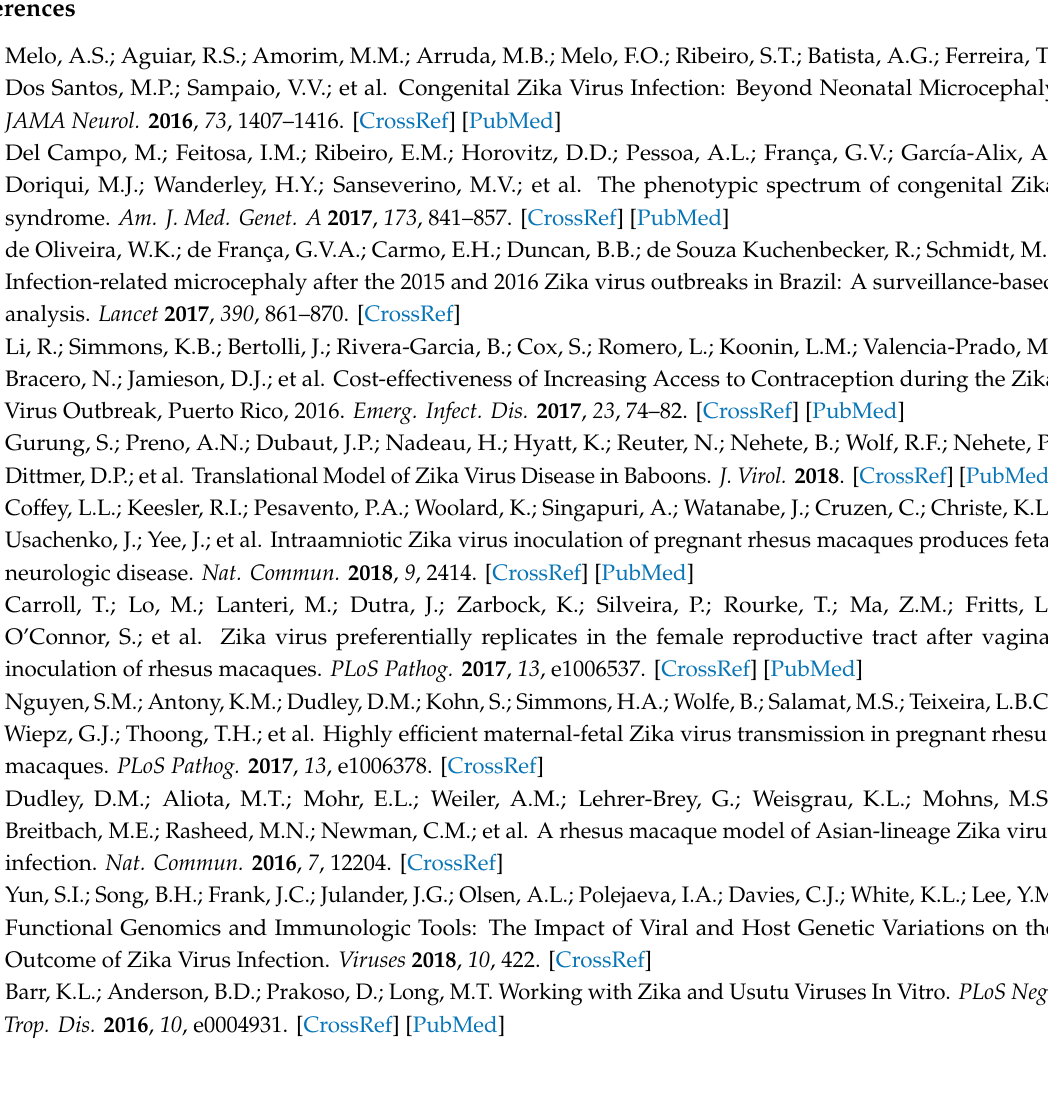
Figure S1: PBMC phenotypes measured by FACS over the course of the study period, reported as the change in percentage of cells from initial pre-infection measurement (standardized to 0 on the y-axis); horizontal lines indicate the mean change in percentage for each group, where blue represents infected animals and orange represents control animals. Specific phenotypes measured included: (a) CD4 + T lymphocytes; (b) CD8 + T lymphocytes; (c) CD14 + monocytes; and (d) γδ T